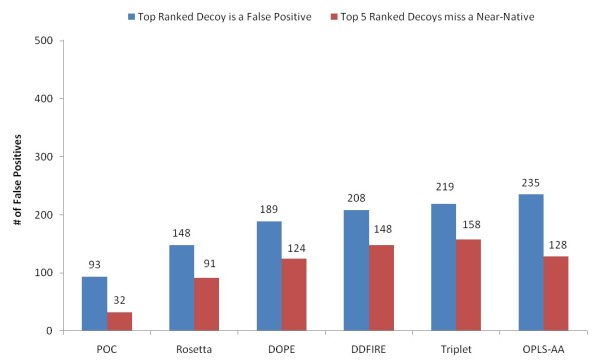
Number of False Positives. Number of cases where the top-ranked decoy is a false positive and the near-native structures are missed in the top-5-ranked decoys in 502 loop targets in the POC method and individual scoring functions